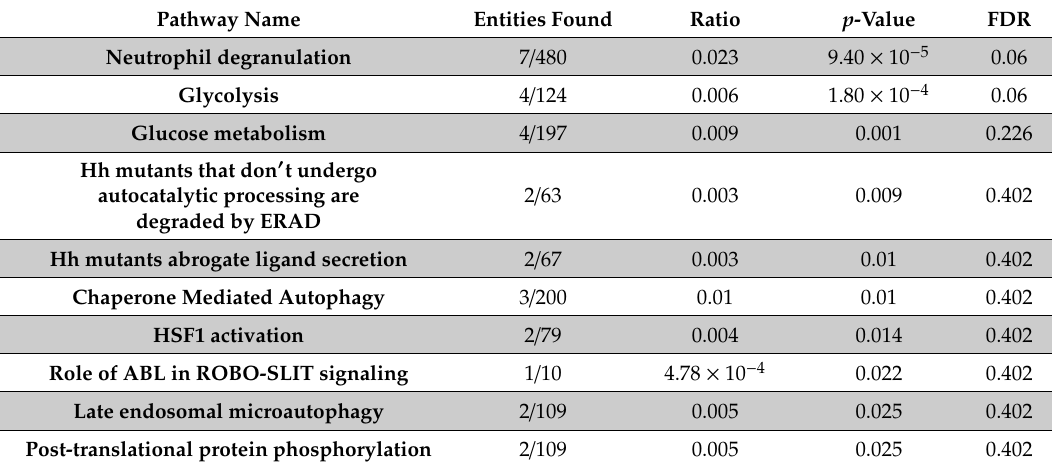
Table 3. REACTOME over-representation results. Entities Found: di ff erentially modulated proteins between RAOM and ATH found belonging to the pathway / total proteins belonging to the pathway. Ratio: numerical ratio between di ff erentially modulated proteins between RAOM and ATH found belonging to the pathway / total proteins belonging to the pathway. p -value: The result of the Binomial Test for over-representation. FDR: False Discovery Rate, Corrected over-representation